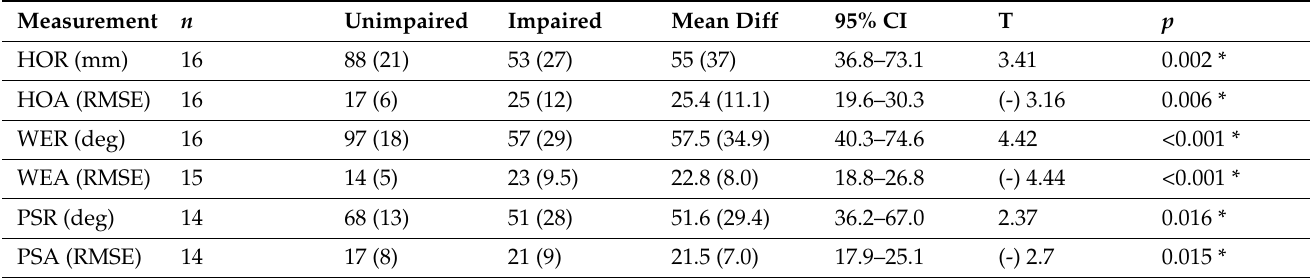
Table 4. Comparisons between Unimpaired and Impaired Upper Extremity